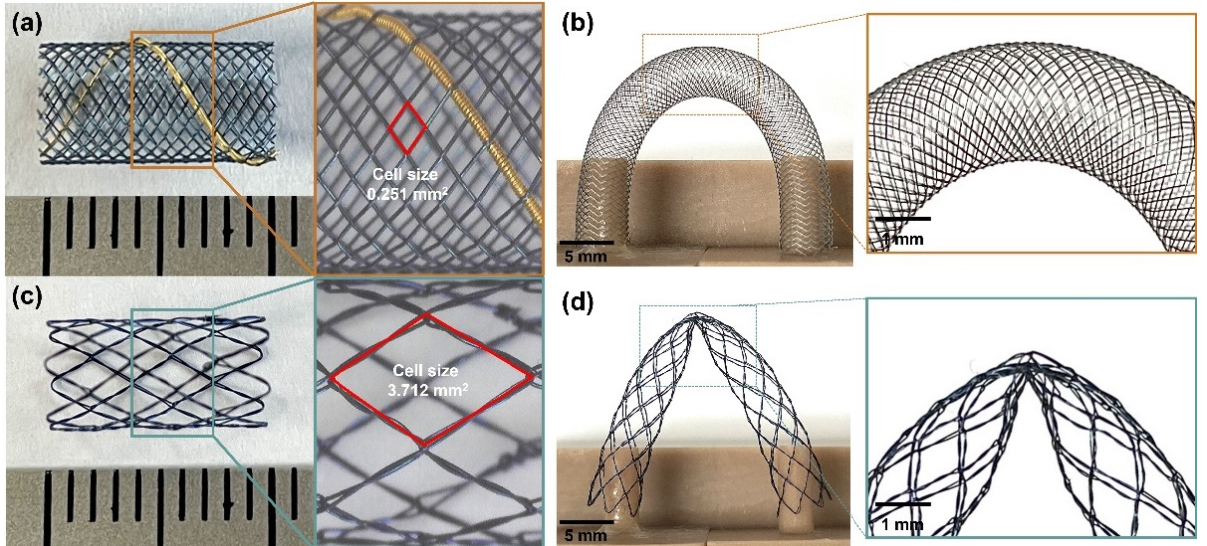
Figure 2. Interwoven and knitted SEMSs. Images showing ( a ) the interwoven SEMS with a mean cell size of 0.251 mm 2 and ( b ) its bending test finding using the phantom. ( c ) Images showing the knitted SEMS with a mean cell size of 3.712 mm 2 . ( d ) the bending test was performed to evaluate the degrees of stent deformation, such as bending and kinking, of the two SEMSs. SEMS, self-expandable metallic stent.